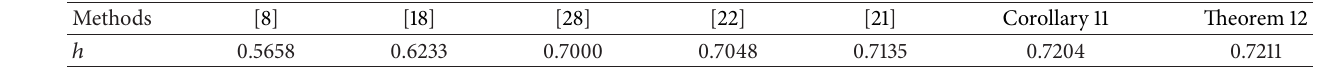
Table 1: Maximum upper bound of ℎ with different methods.